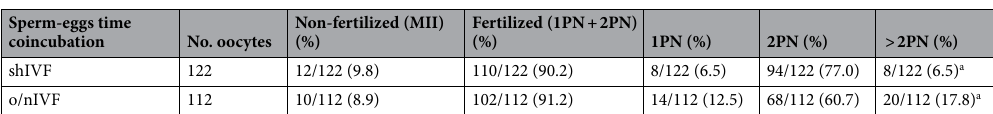
Table 1. Polyspermy rate. Pronuclei were evaluated after 14 h from IVF starting. Polyspermic zygotes (> 2PN) were higher in o/nIVF than shIVF group. Oocytes with at least one visible pronucleus were considered as fertilized (1PN + 2PN). Values with similar superscript differs significantly ( P < 0.05).